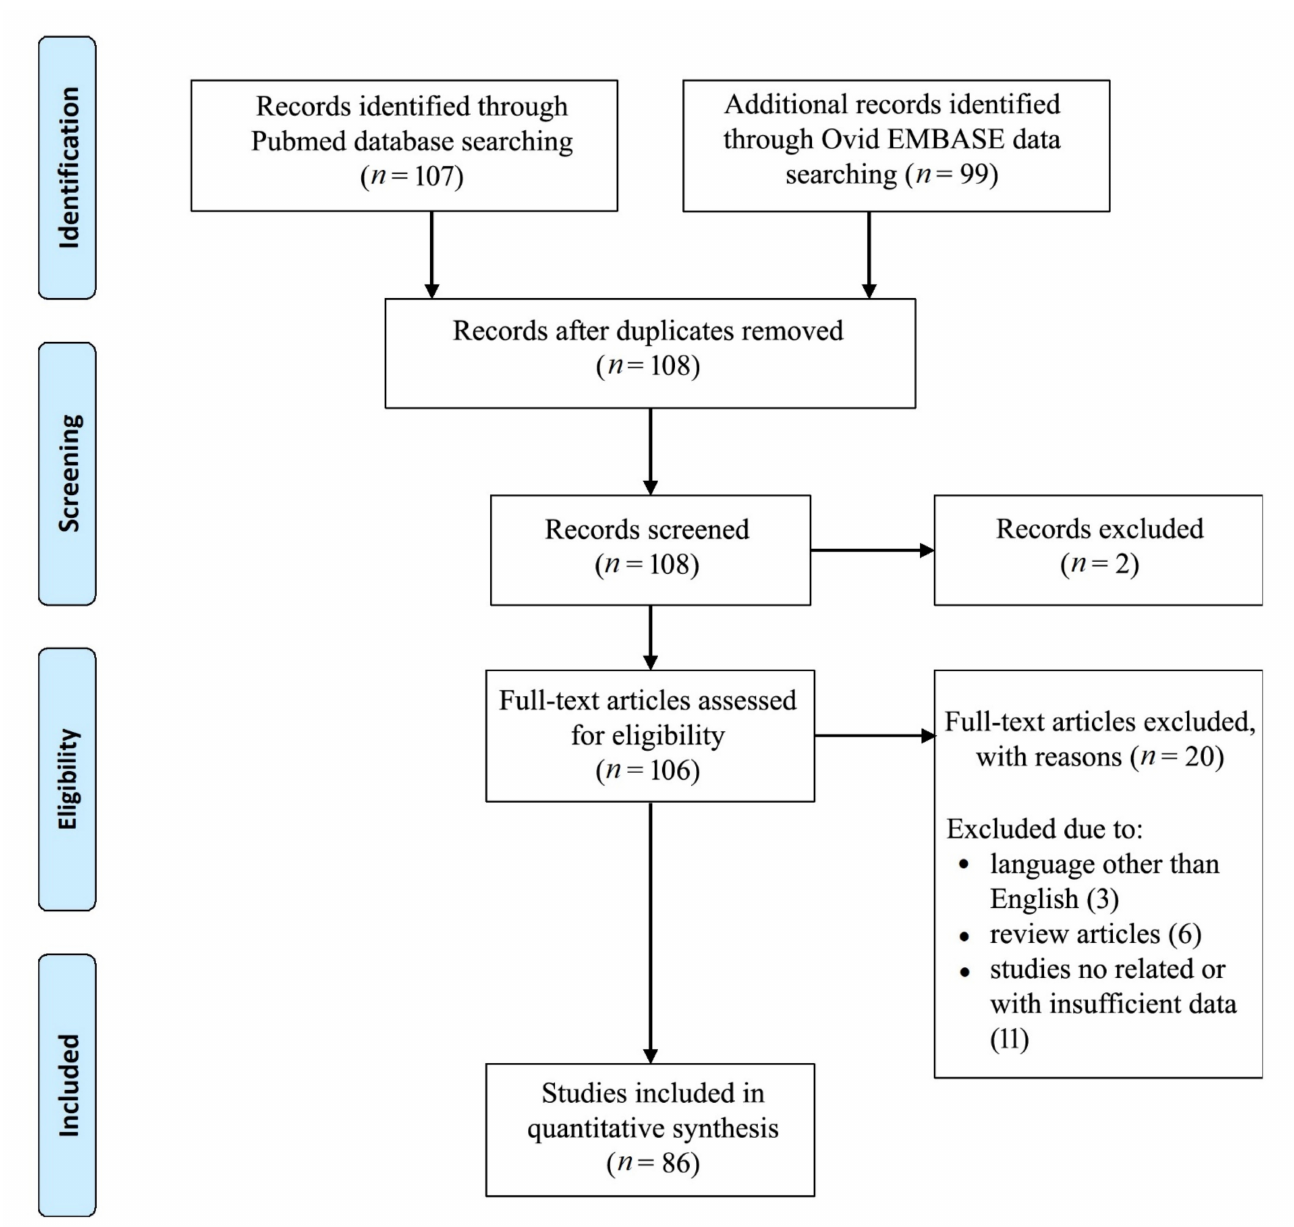
Figure 1. PRISMA flow